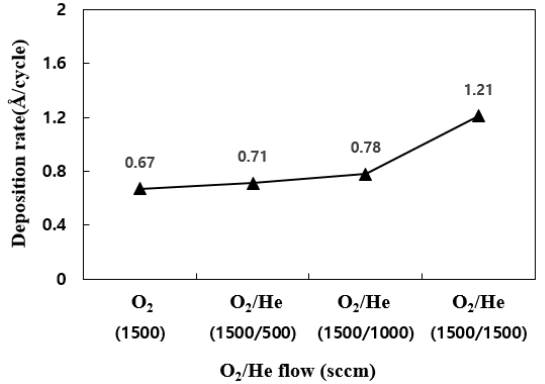
Figure 6. Reactant gas O 2 : deposition rate trend according to He flow rate.